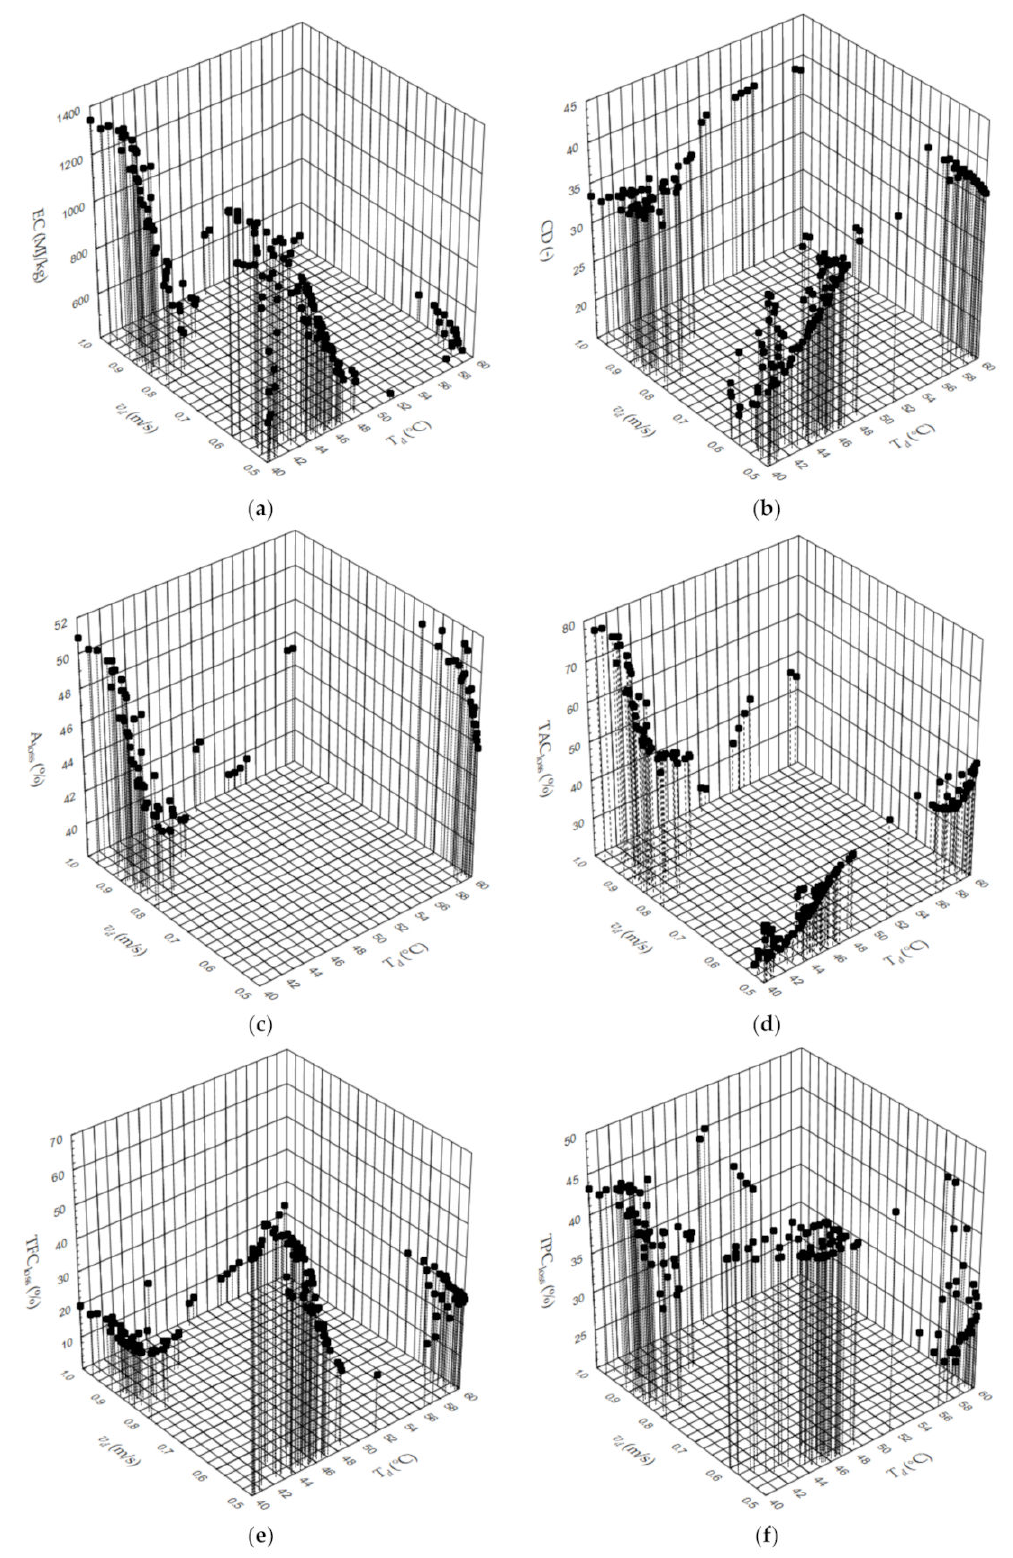
Figure A1. The impact of T d and v a on: ( a ) EC, ( b ) CD, and quality parameters ( c ) A loss , ( d ) TAC loss , ( e ) TFC loss , ( f ) TPC loss of the Echium amoenum